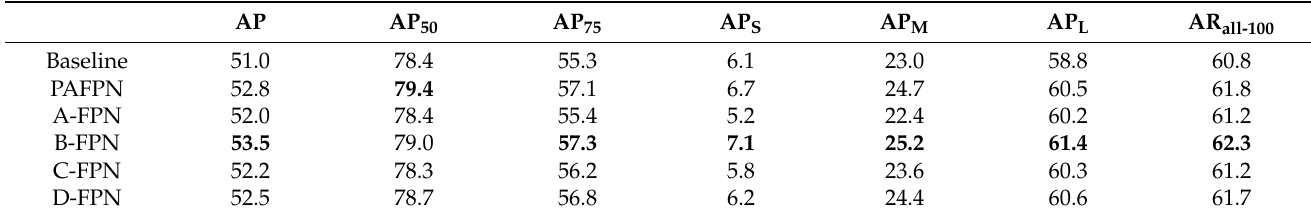
Table 2. Comparison of different FPN structure detection results.